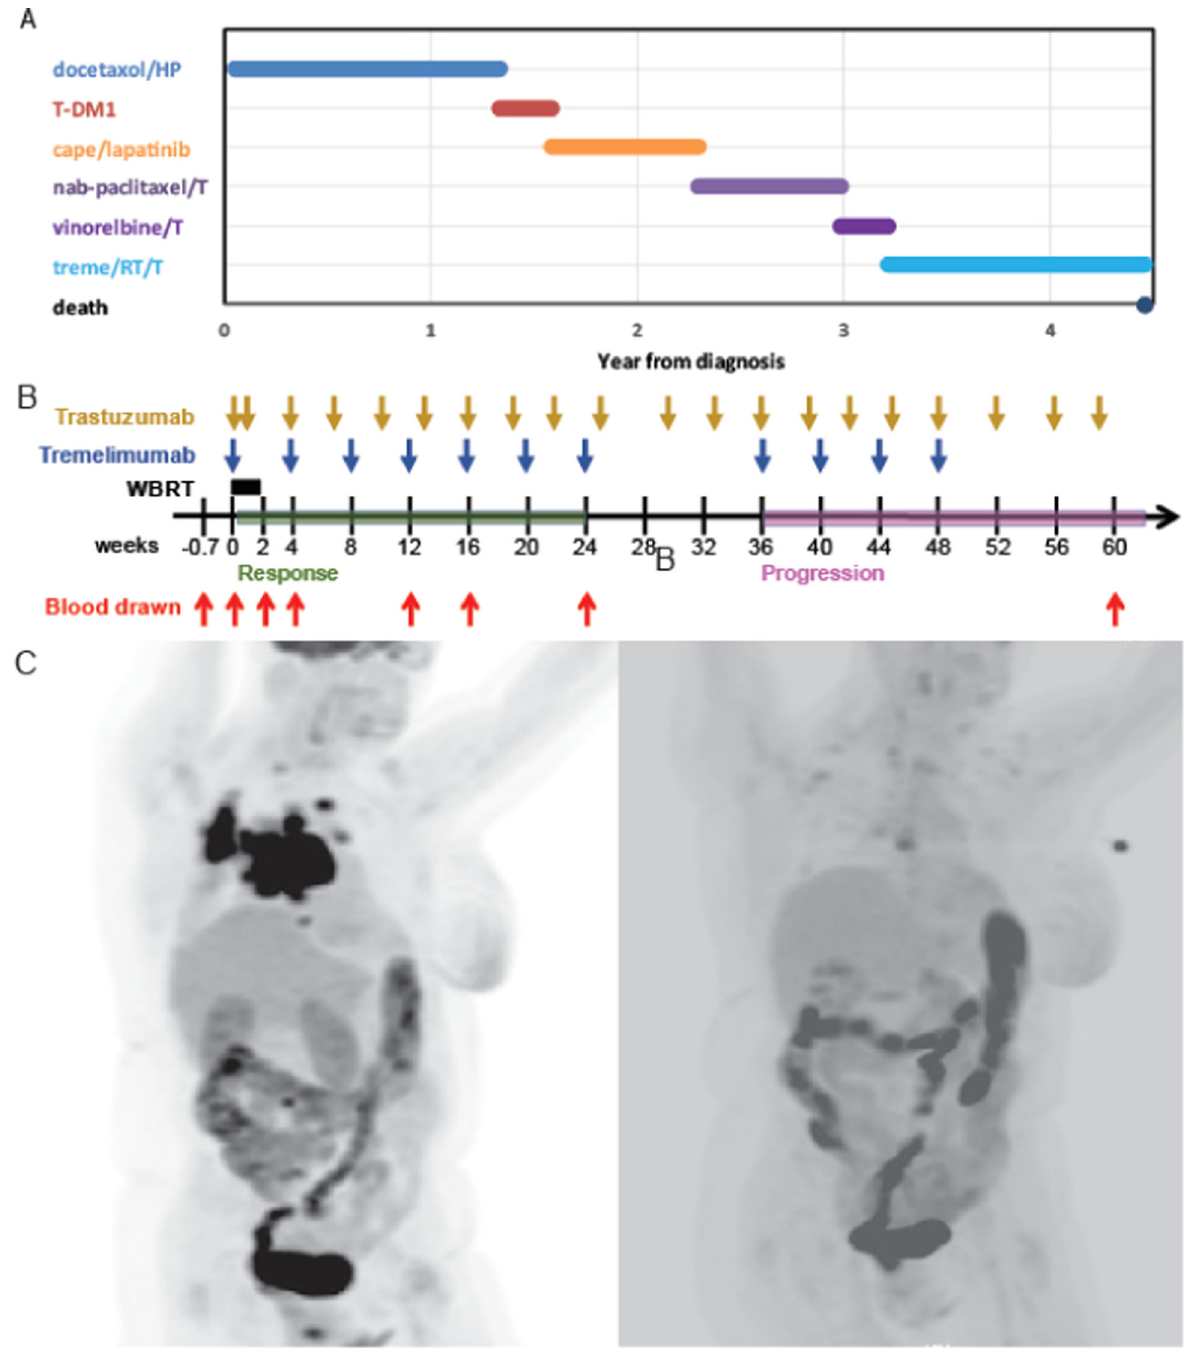
Fig. 3 HER2 + responder treatment schedule and radiological response. A Prior therapies. B Treatment timeline and blood draws (red) for the patient who responded to tremelimumab (blue) and WBRT (black rectangle) with trastuzumab (gold), showing when she responded (green) to when she relapsed (pink). C Baseline (left) and week 12 (right) PET/CT demonstrating a non-CNS PR in a woman treated with concurrent tremelimumab and WBRT with HER2-directed therapy that was durable at 6 months. H trastuzumab, P pertuzumab,